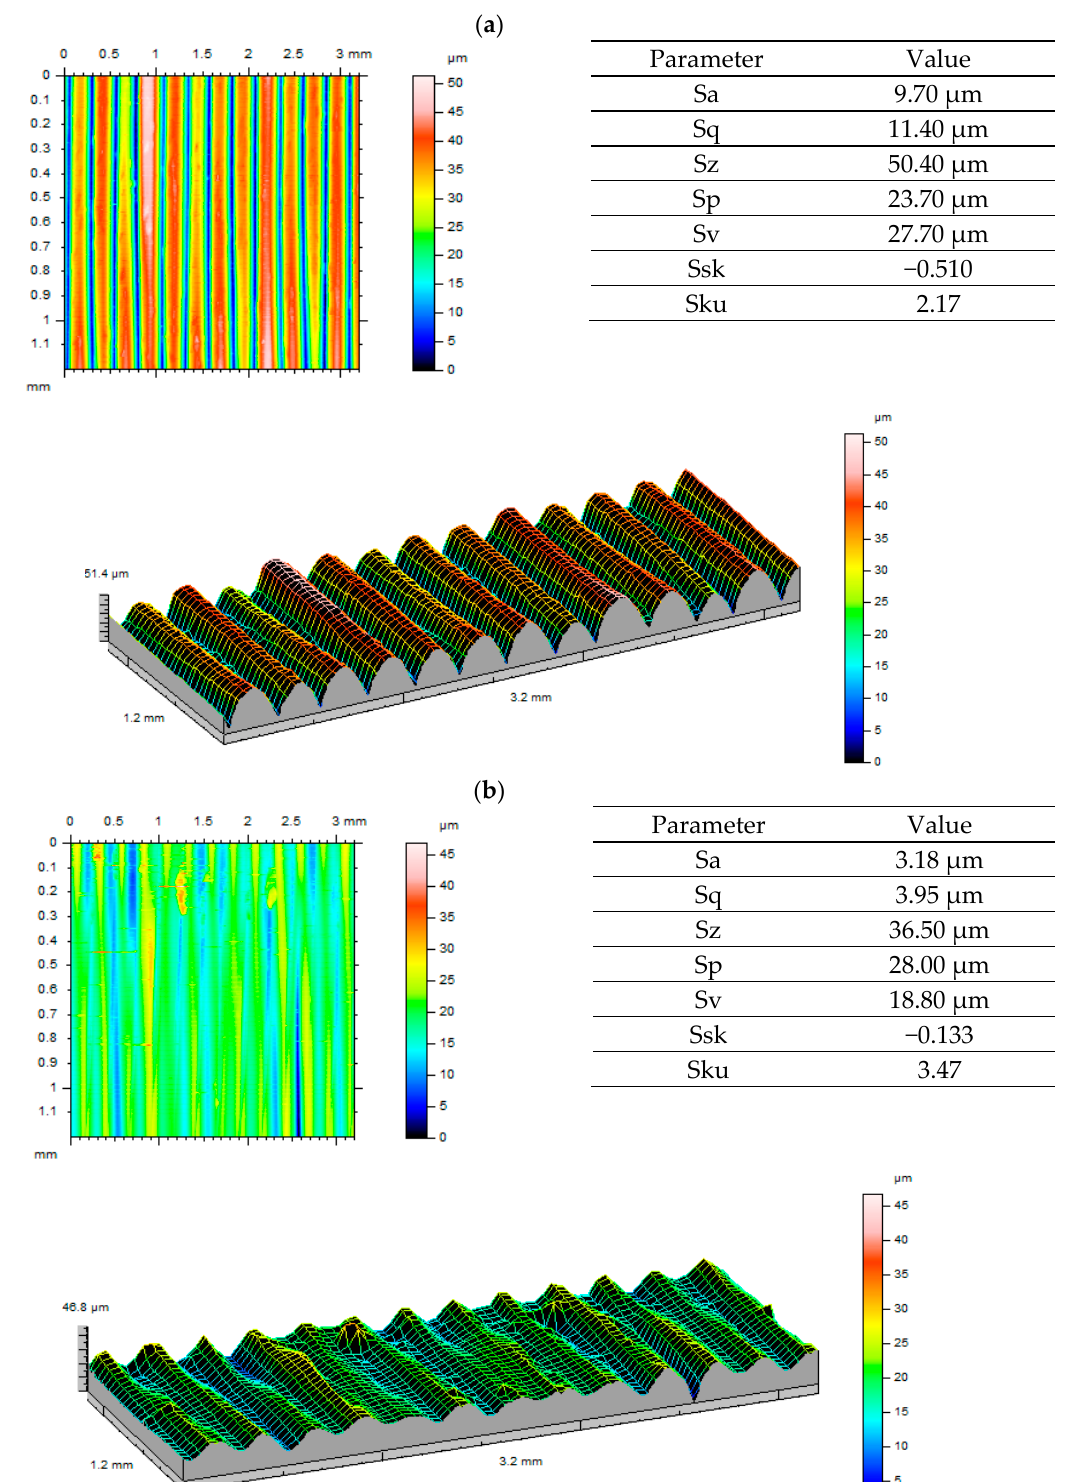
Figure 11. Roughness measurement results for the ULTEM material: ( a ) before testing; ( b ) after testing.